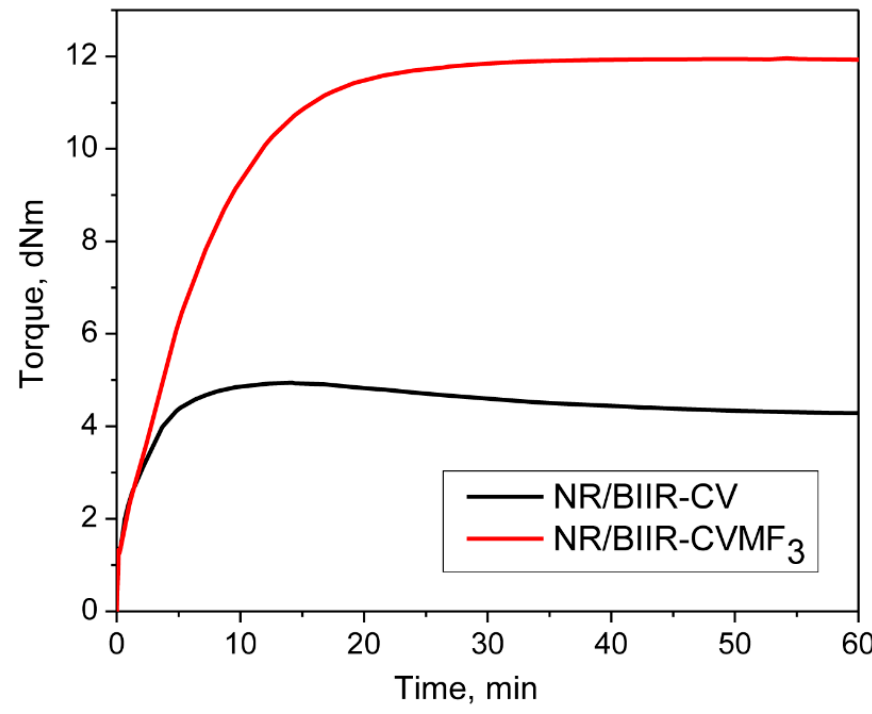
◦ C for 1 h. Figure 3. Curing curves of NR/BIIR-CV and NR/BIIR-CVM3 at 170 °C for 1 h. Figure 3. Curing curves of NR/BIIR-CV and NR/BIIR-CVM3 at 170 The improved tensile properties confirm the fact that the compatibility between NR and BIIR has been enhanced after curing the blend with a combination of CV and bis- maleimide. To further check the strength of the cured network that has been created in NR/BIIR via the above-mentioned compatibilization reaction with the help of CV/MF 3 , the CS property of NR/BIIR-CVMF 3 was measured and reported in Table 4. For the purposes of comparison, the CS properties of NR-CVMF 3 and BIIR-CVMF 3 were also measured and depicted in the same Table. The CS value that has been observed in NR/BIIR-CV could be reduced from 64.5% to 29.4% after curing with 3 phr of MF. One of the reasons for this could be the formation of thermally stable bismaleimide-based adduct-type crosslinks in its vulcanized network. The TS and CS values of NR/BIIR-CVMF 3 reveal the fact that the NR phase has substantial sulfidic crosslinks even after curing with MF. This might be one of the reasons for its enhanced TS. On the other hand, these sulfidic crosslinks are responsible for the relatively high CS value in NR/BIIR-CVMF 3 compared to BIIR-CVMF 3